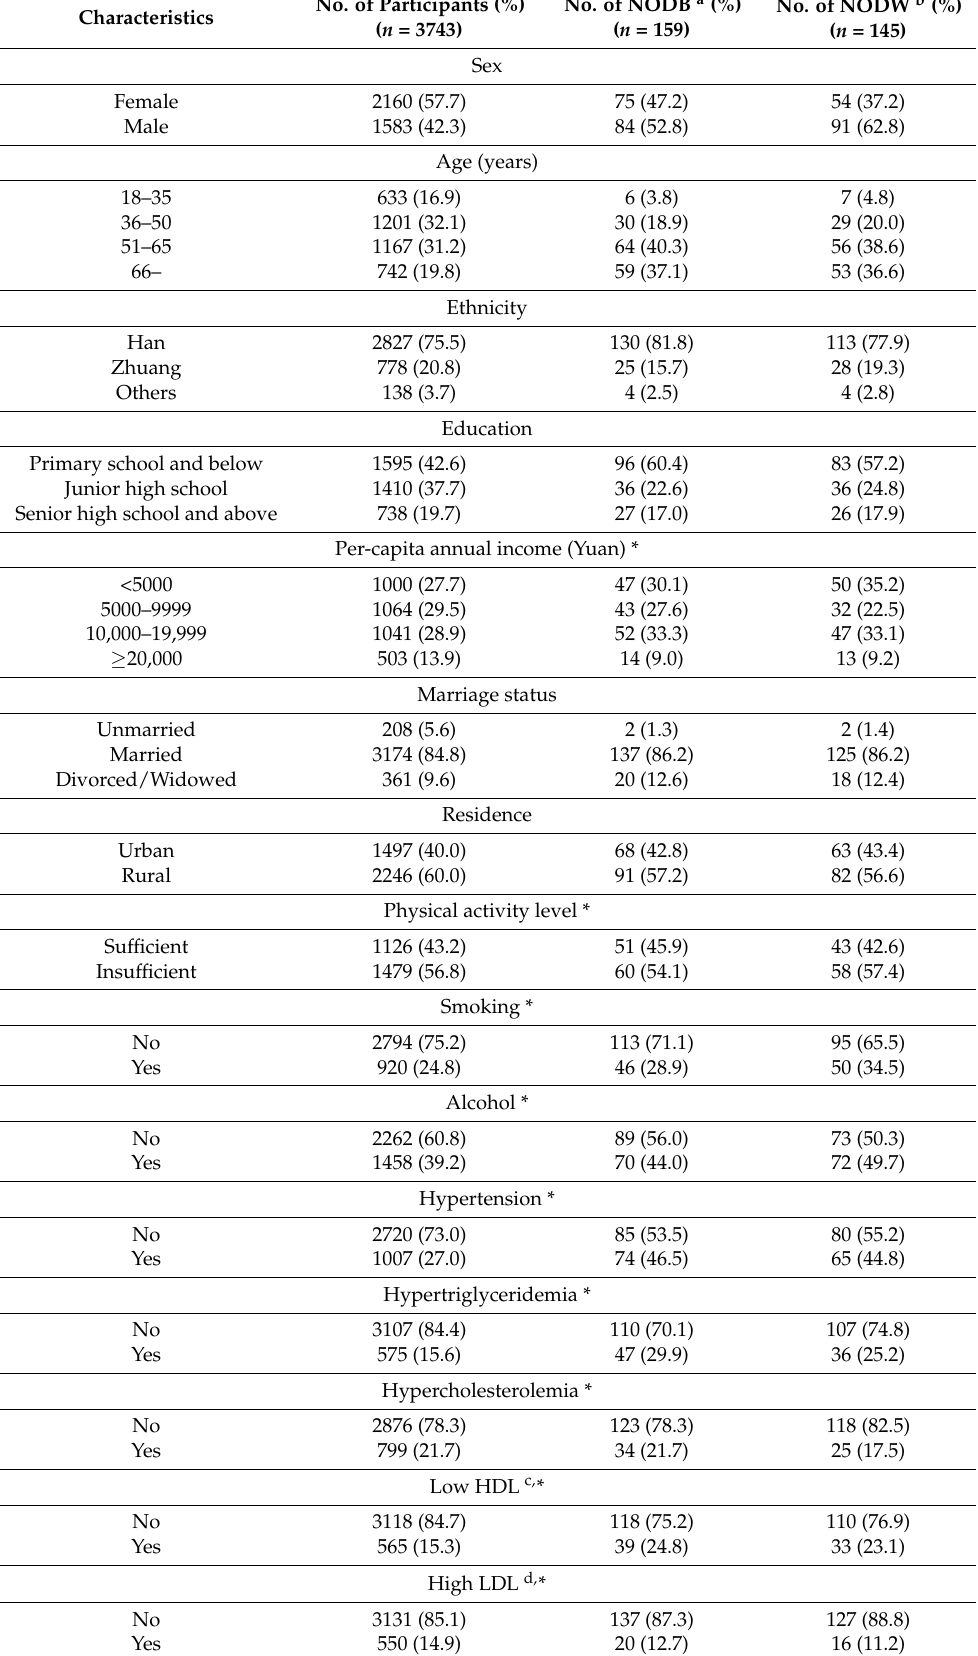
Table 1. Characteristics of newly diagnosed and non-obese diabetes mellitus in Guangxi.